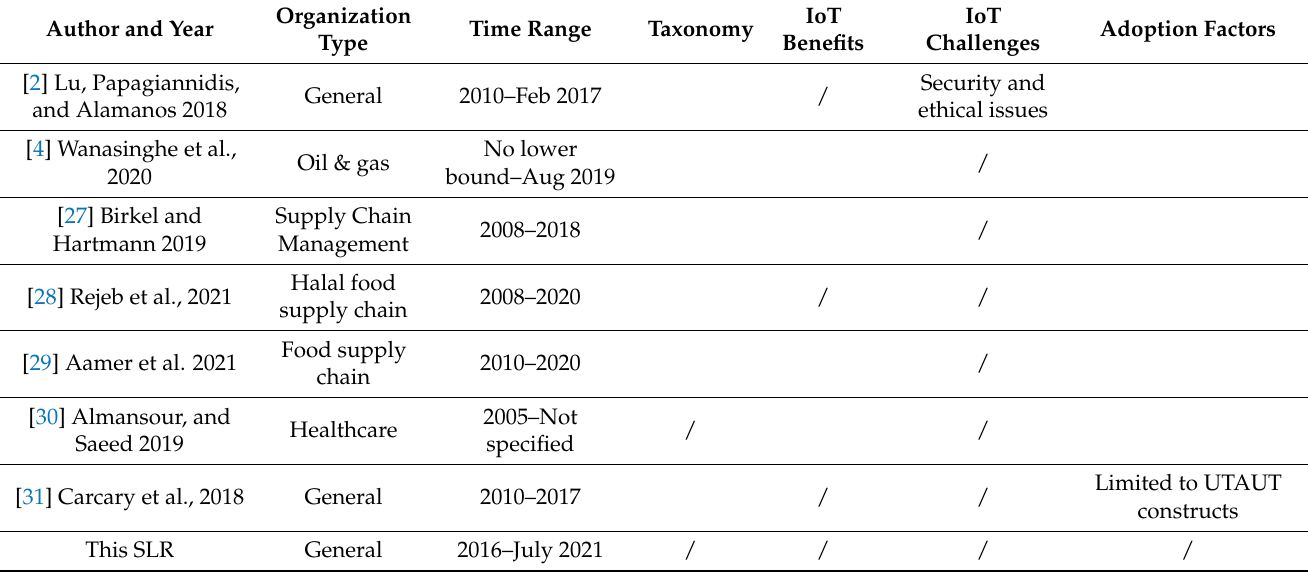
Table 1. Comparison between existing systematic reviews and this